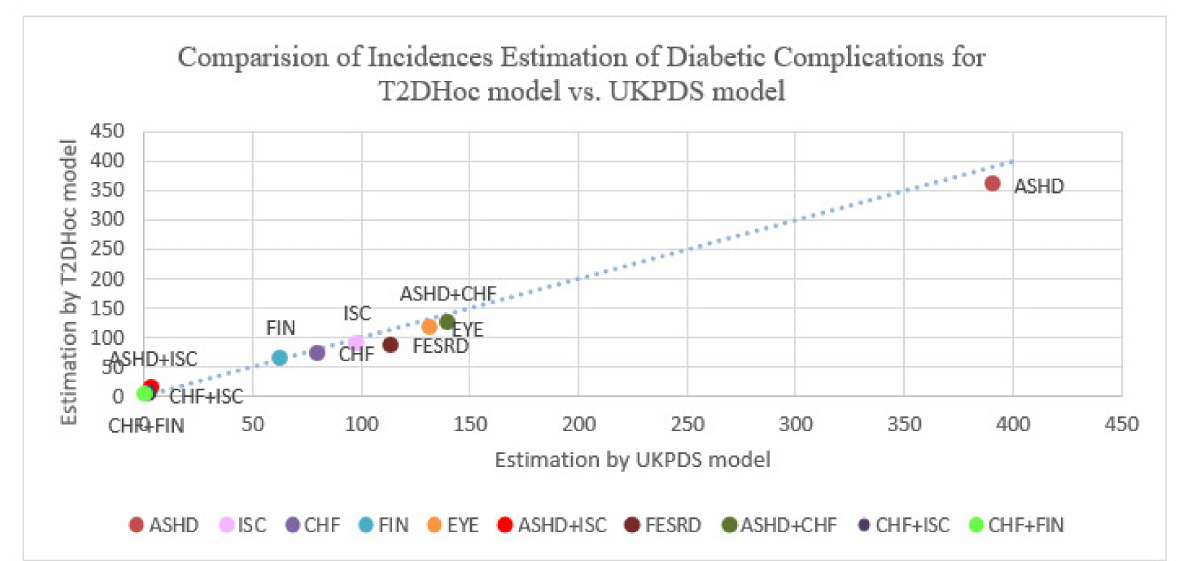
Figure 10. Comparison of incidence rates estimation of diabetic complications for UKPDS vs. T2DHoc models with 3867 hypothetical patients in 10 years. Abbreviation: ASHD, arteriosclerotic heart disease; CHF, chronic heart failure; T2D, type 2 diabetes mellitus; EYE, retinopathy; FESRD, first-time renal failure; FIN_FOOT, amputation; ISC, ischemic